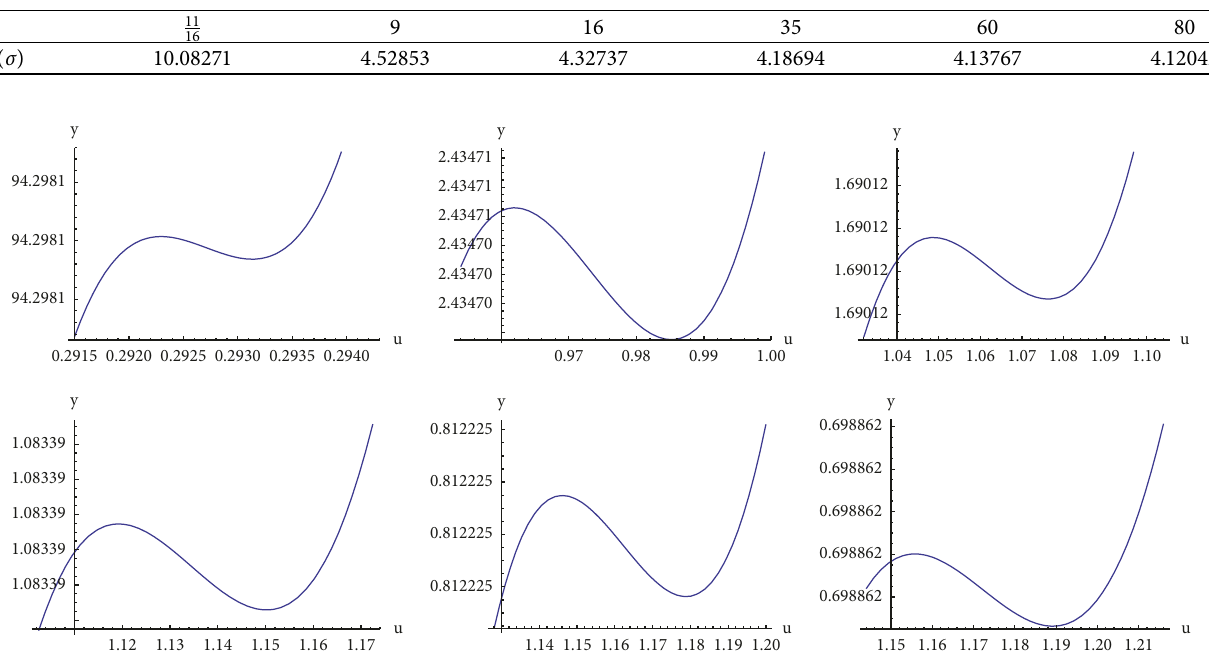
Table 4: The numerical results for S ( σ ) .